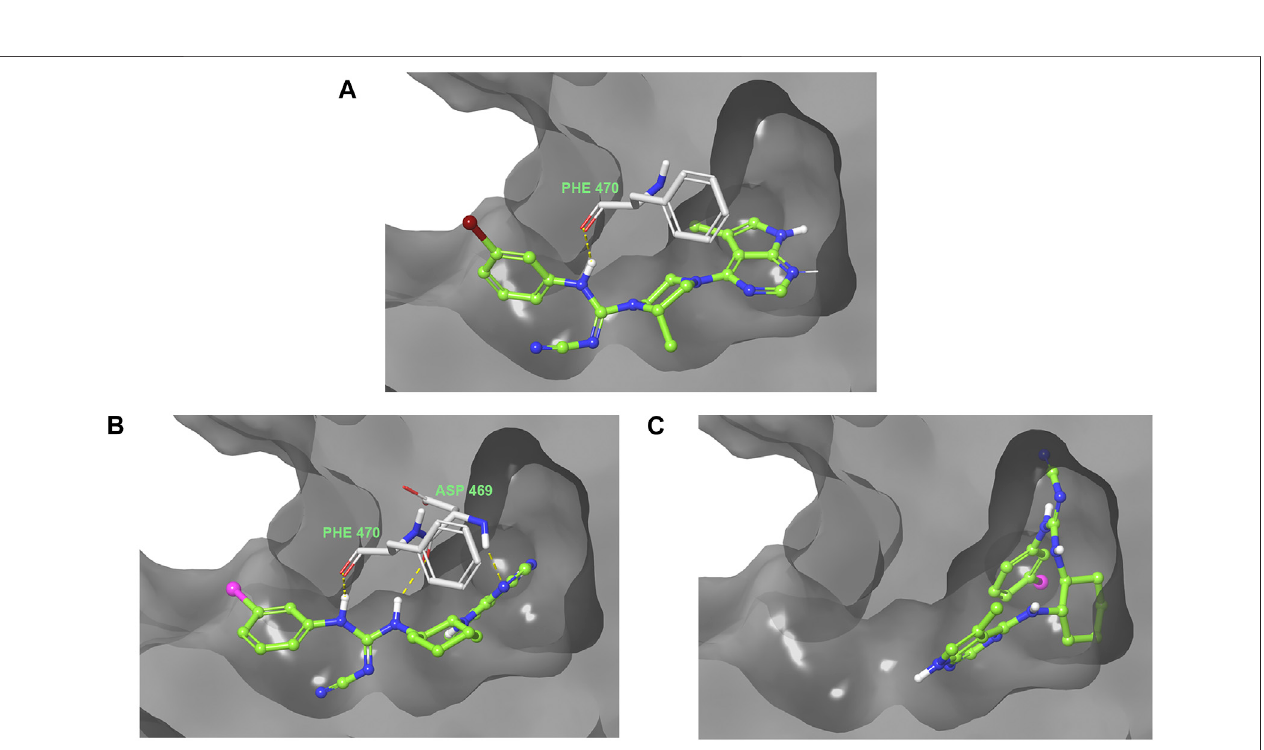
FIGURE 5 | Predicted binding poses of ligand 1 (A) , 24 (B) , and 26 (C) into the ATP-binding pocket of LIMK2.